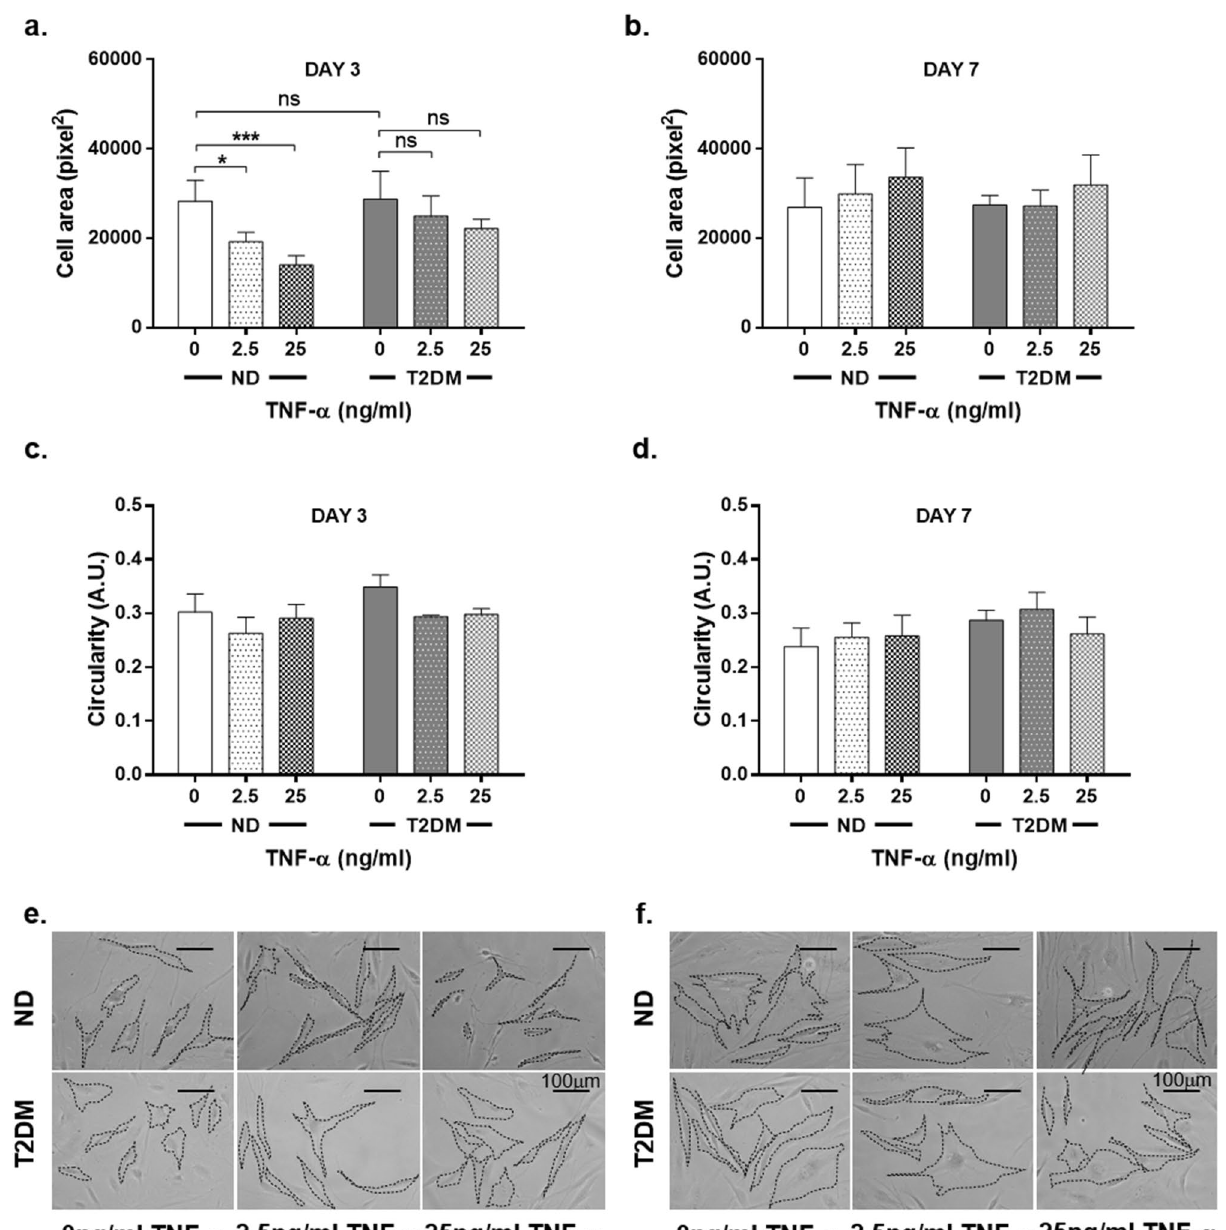
Figure 2. TNF-α has a differential effect on ND-DF and T2DM-DF morphology. The morphology of DF in images taken from the senescence assay were analysed using Image J. ( a ) Mean spread cell area and ( b ) circularity of ND- and T2DM-DF at day 3 post-TNF-α withdrawal (both n = 4 donors). ( c ) Representative images. ( d ) Mean spread cell area and ( e ) circularity of ND-DF and T2DM-DF at day 7 post-TNF-α withdrawal (both n = 4 donors). ( f ) Representative images. Two-way ANOVA with Sidak post-hoc test * P < 0.05, *** P < 0.001, ns =